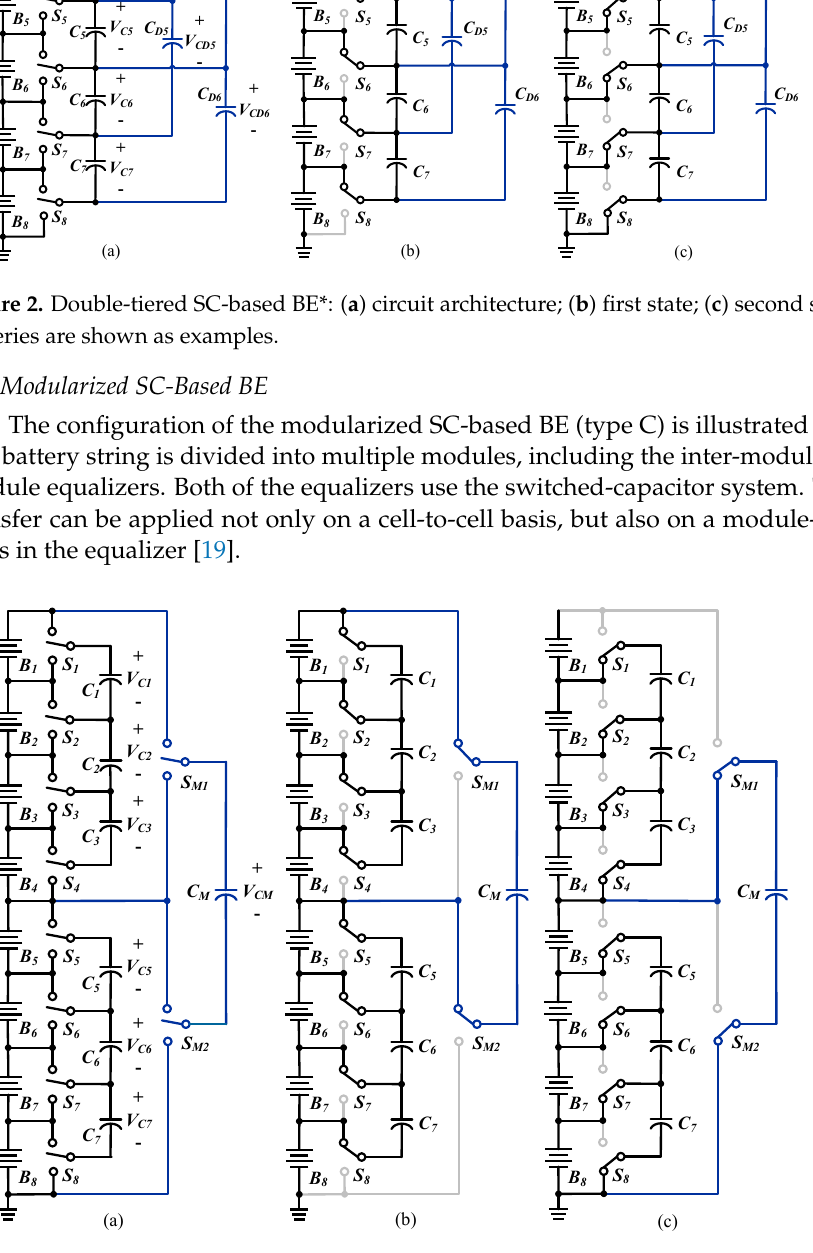
Figure 3. Modularized SC-based BE*: ( a ) circuit architecture; ( b ) first state; ( c ) second state. * Eight batteries are shown as